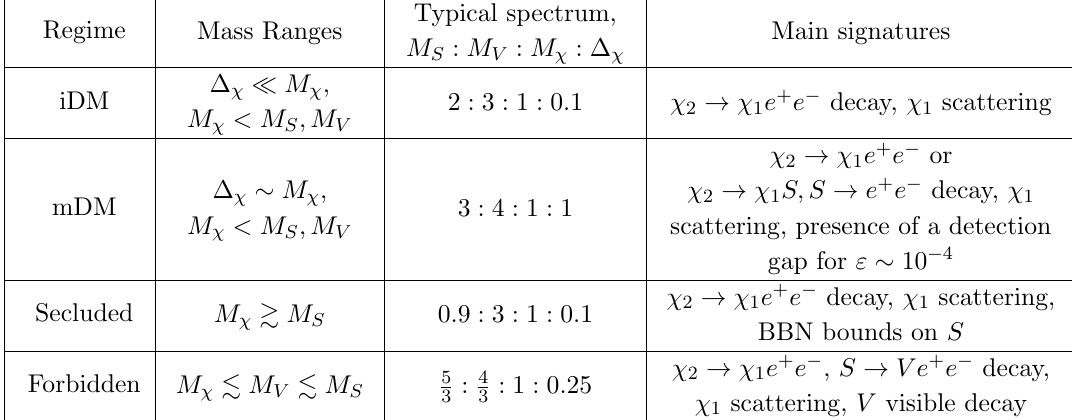
Table 1. Summary of the main features of the four identi(cid:12)ed regimes, including their typical spectrum with viable dark matter candidate, and main possible signatures from astrophysical ob- servations and in beam-dump